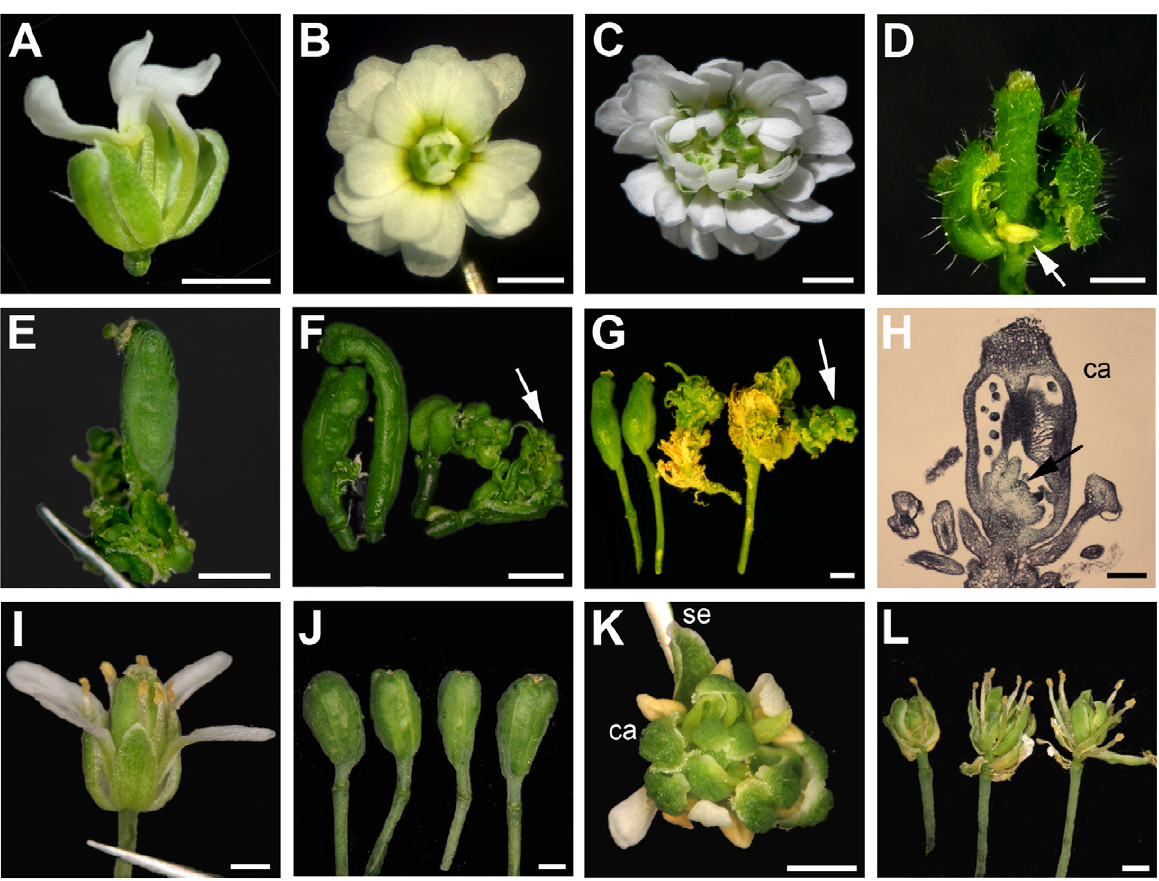
Figure 4. Genetic interactions between AGO10 and meristem regulators. (A) A hua1 hua2 ago10-12 wus-1 flower. wus-1 was completely epistatic to hua1 hua2 ago10-12 in floral determinacy such that the quadruple mutant flower had an incomplete set of floral organs as in a wus-1 flower. (B) An ag-1 flower. (C) An ag-1 pnh-1 flower that had apparently more floral organs than an ag-1 flower and showed signs of fasciation. (D,E) ap2-2 partially suppressed the floral determinacy defects of hua1 hua2 ago10-12 and ag-10 ago10-13 . (D) A representative of the non-bulged gynoecia of some hua1 hua2 ago10-12 ap2-2 flowers. The petaloid stamens in hua1 hua2 ago10-12 were rescued back to stamens (arrow) by the ap2- 2 mutation. (E) A representative of ag-10 ago10-13 ap2-2 gynoecia, which are longer than ag-10 ago10-13 gynoecia (Figure 2E). (F–H) phb-1d and phv- 5d each enhanced the determinacy defects of ag-10 . (F) ag-10 phb-1d/ + siliques. Ectopic floral organs, indicated by the arrow, were found in the siliques of most ag-10 phb-1d/ + flowers. (G) ag-10 phv-5d siliques were bulged or contained ectopic floral organs, as indicated by the arrow. (H) A longitudinal section of an ag-10 phb-1d/ + gynoecium. An ectopic floral meristem (indicated by the arrow) could be observed inside the carpels. (I–L) ag-10 plants harboring transgenic amiR165/166 exhibited loss of floral determinacy. (I–J) Weaker determinacy defects of some ag-10 amiR165/166 plants. The gynoecia were bulged as in ag-10 ago10-13 . (K–L) Stronger determinacy defects of some ag-10 amiR165/166 plants. The gynoecia were replaced by an internal flower. Scale bars, 50 m m in (H), and 1 mm in all other panels. ca, capel; se, triple mutant were restored to stamens in the quadruple mutant (Figure 4D). While the third whorl organs in hua1 hua2 ago10-12 had patches of cone-shaped cells reminiscent of petal epidermal cells (Figure S3I, S3J), the third whorl organs in hua1 hua2 ago10-12 ap2-2 had epidermal cells with the shapes of interlocking puzzle pieces resembling anther epidermal cells (Figure S3K,S3L). This indicates that the homeotic transformation in hua1 hua2 ago10-12 flowers is due to de-repressed AP2 and that AGO10 mediates the function of miR172 in repressing AP2 . Second, ap2-2 partially and ag-10 ago10-13 flowers. ap2-2 did not affect the shapes of hua1 hua2 or ag-10 gynoecia ([31]; Figure S3M), but caused hua1 hua2